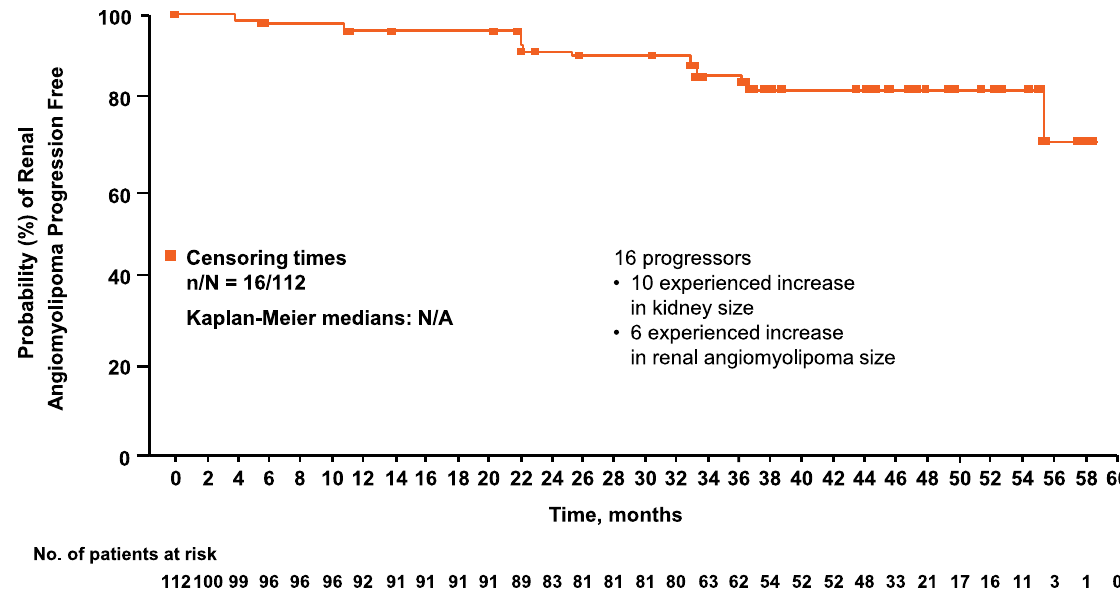
(68.2%; 95% CI, 58.5%–76.9%; complete clinical response [n = 1, 0.9%; 95% CI, 0.0%–5.1%]